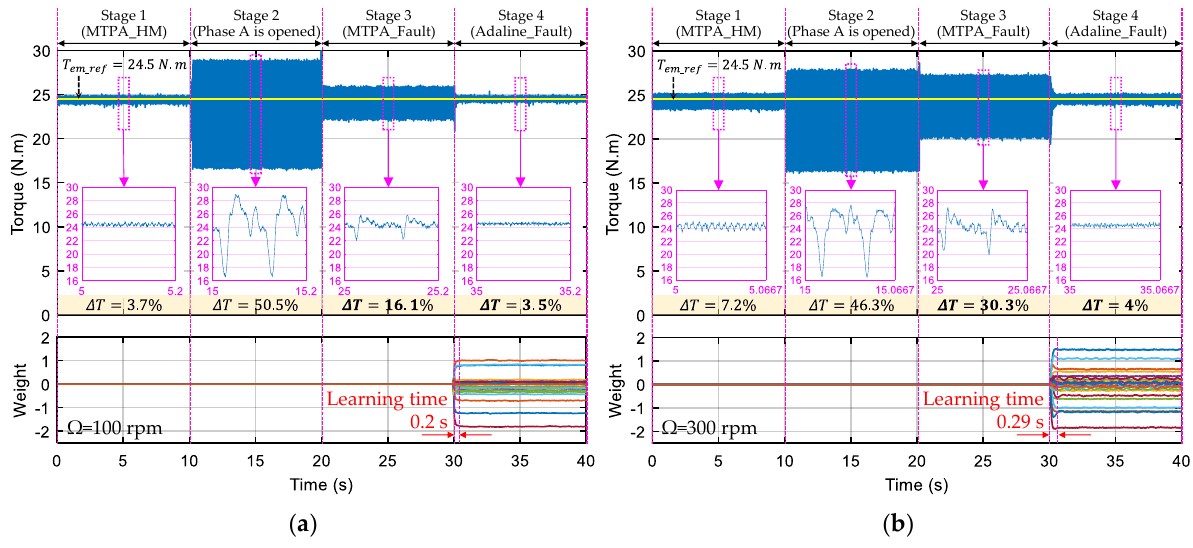
Figure 9. (Experimental result) The torque performance and 23 Adaline weights in the four operating stages in which stage 4 applies the proposed scheme using Adaline_Fault ( η = 0.01) and ECL strategy: ( a ) at 100 rpm; and ( b ) at 300 rpm.